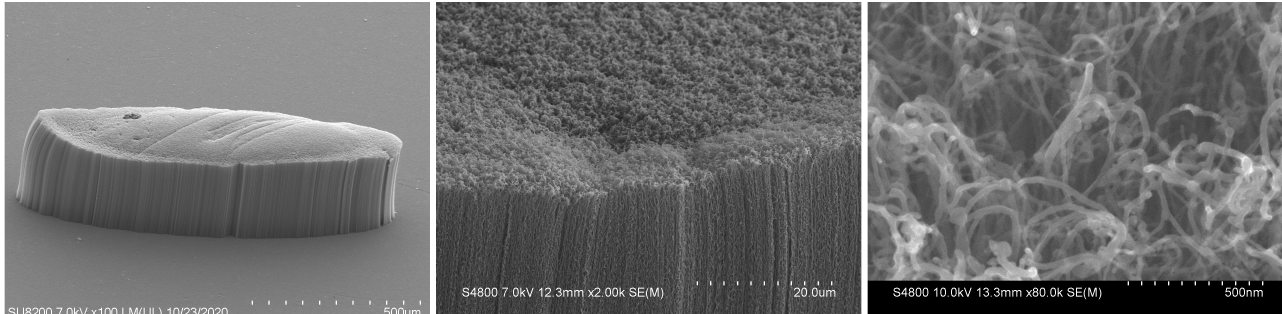
Figure 10. SEM images of CNTs films used in the